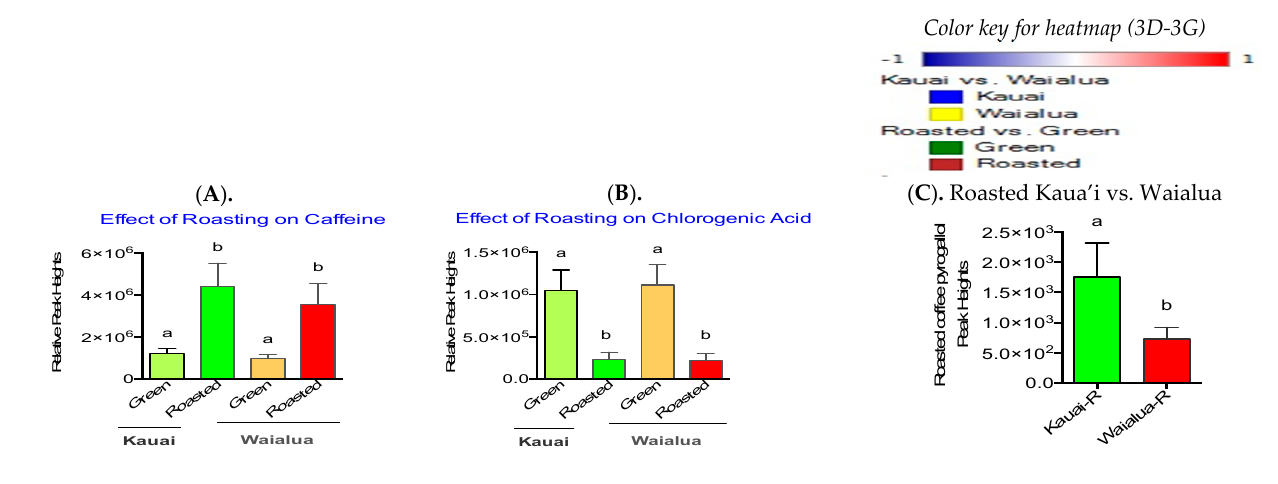
( D ) Figure 2. OPLS-DA score plots for brews of roasted Kaua’i coffee (KR, n = 3) and roasted Waialua coffee (WR, n = 3) for known ( A ) global metabolites, ( B ) positive ESI mode lipids, ( C ) negative ESI mode lipids, and ( D ) biogenic amines. = Kaua’i roasted (KR) and = Waialua roasted (WR). 3.2. Influence of Roasting on Metabolites, Lipids, and Biogenic Amines of “Kona Typica” (Waialua) and “Yellow Catuai” (Kaua’i) Coffee Brews As expected, roasting significantly increased caffeine and reduced chlorogenic acid in both coffee varieties (Figure 3A and Figure 3B, respectively). Similar effects of roasting on caffeine and chlorogenic contents of coffee have been reported by others [100]. Roasted Kaua’i coffee contained significantly high amounts of pyrogallol (Figure 3C, p < 0.05) compared to Waialua coffee. Overall differences in Kaua’i and Waialua coffee varieties as